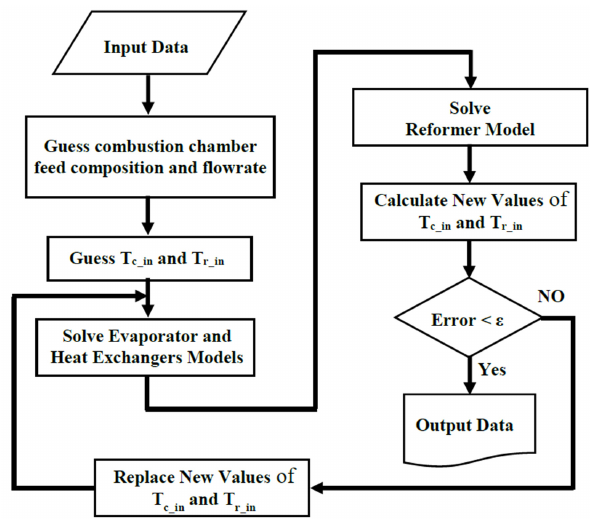
Figure 5. The flowchart of the program for solving the on-board MSR processor model.